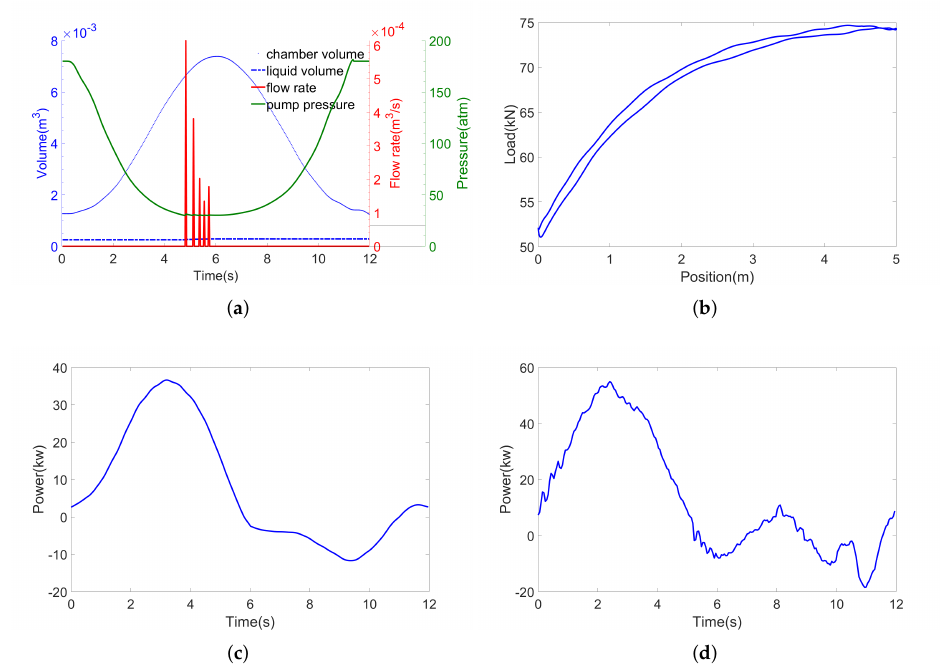
Figure 10. Gas locking working state. ( a ) Pump simulation. ( b ) Generated DC. ( c ) Generated MPC. ( d ) Actual